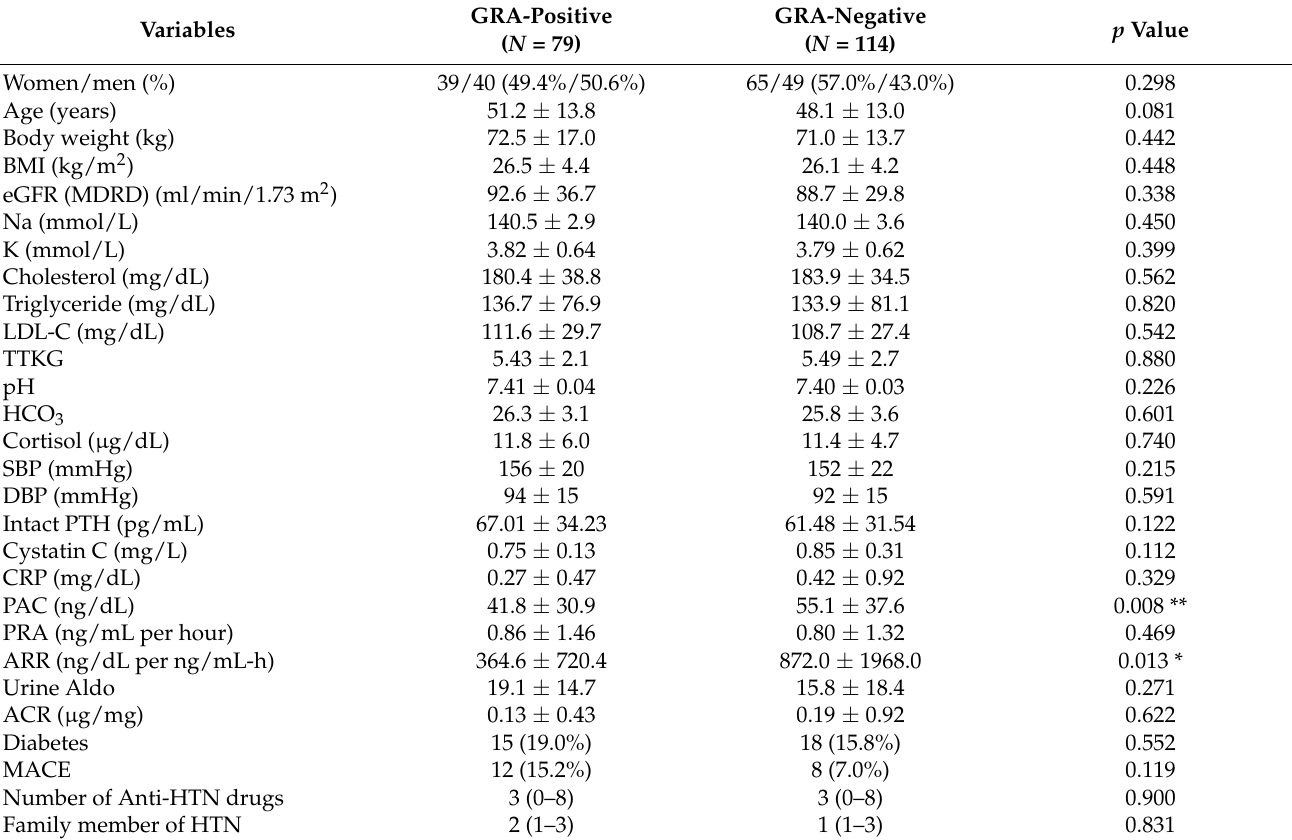
Table 1. Basic characteristics of GRA-positive and GRA-negative PA patients.